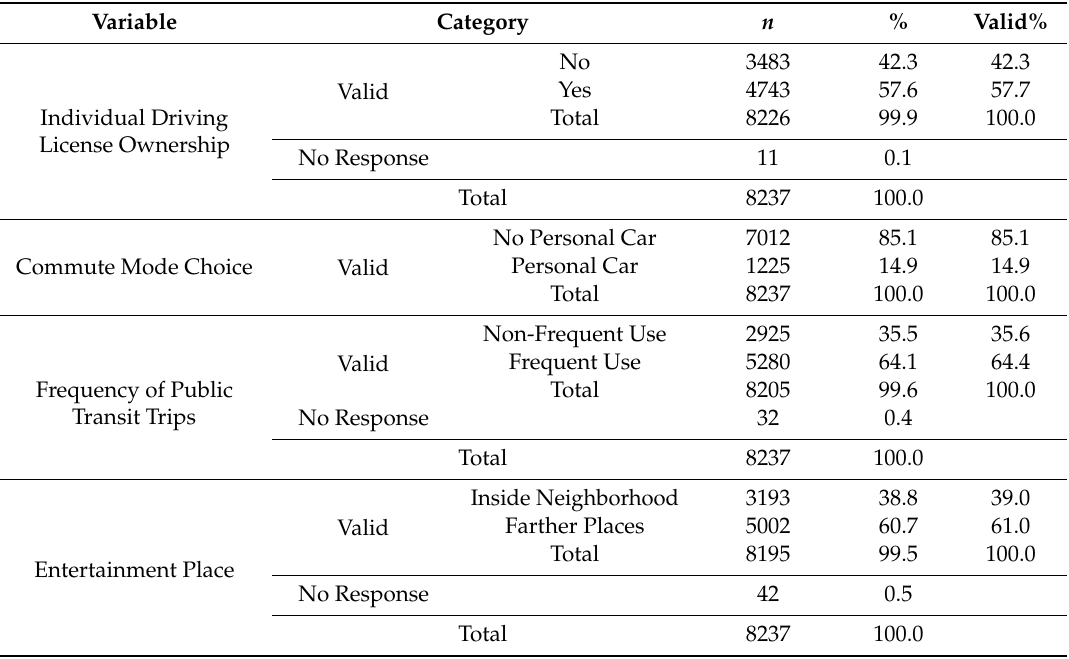
Table 3. Categorical variables of the WLS models.